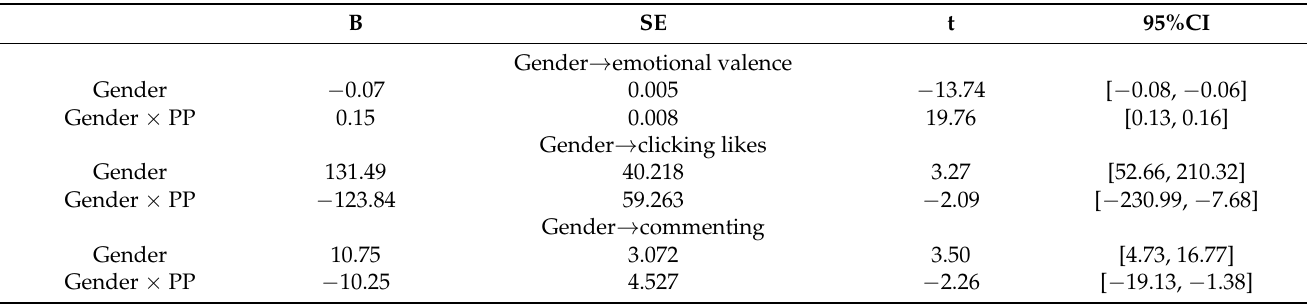
Table 3. The moderating effect of pandemic proximity